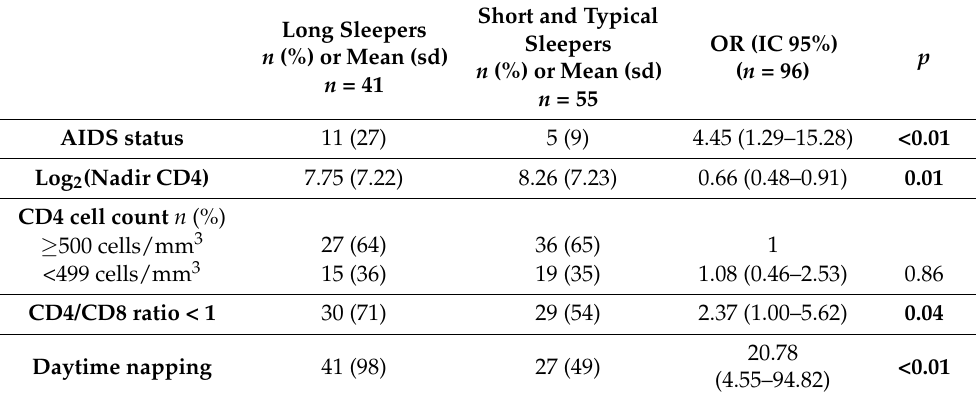
Table 3. Factors associated with long sleepers in persons living with